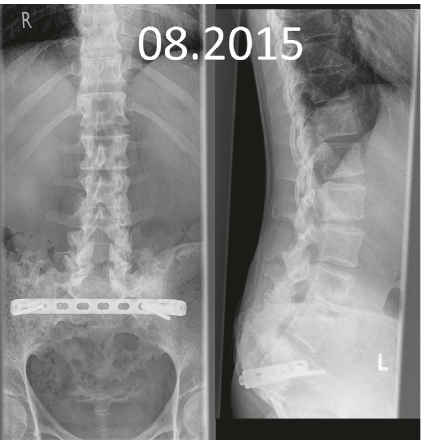
Figure 10: X-ray control in the lower